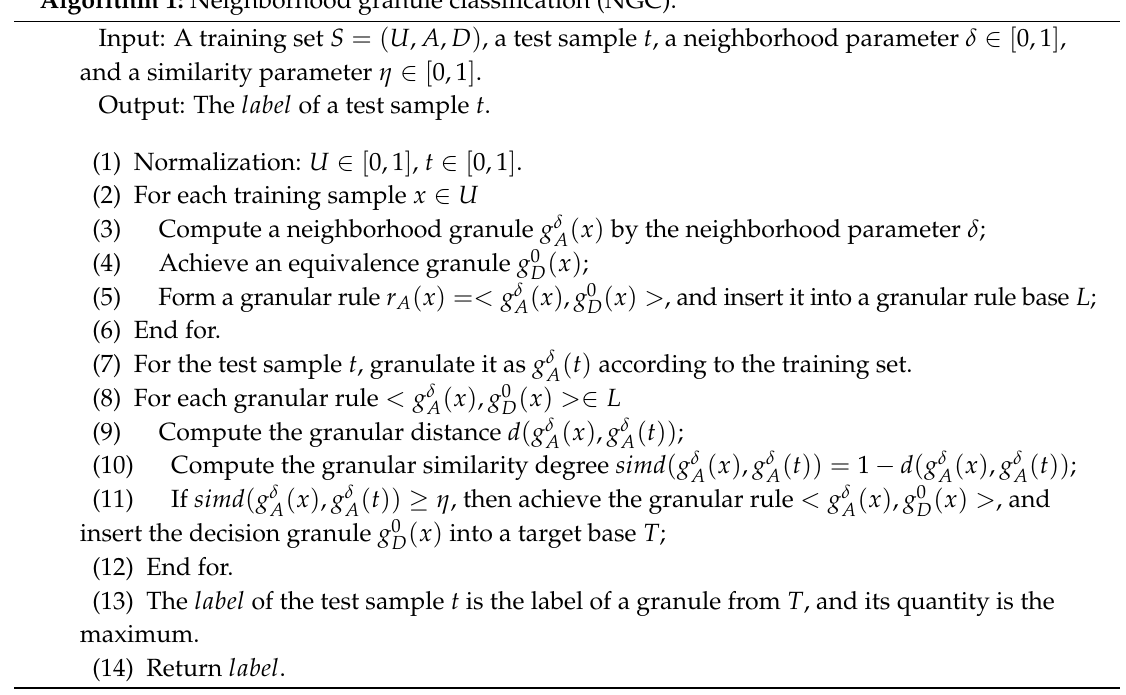
Algorithm 1: Neighborhood granule classification